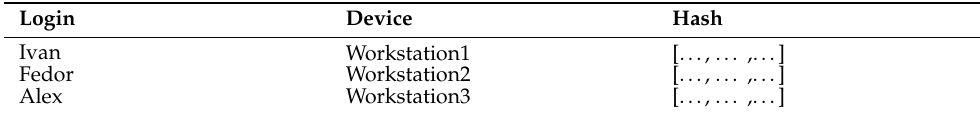
Table 11. Example of query results of the algorithm for Feature 6.